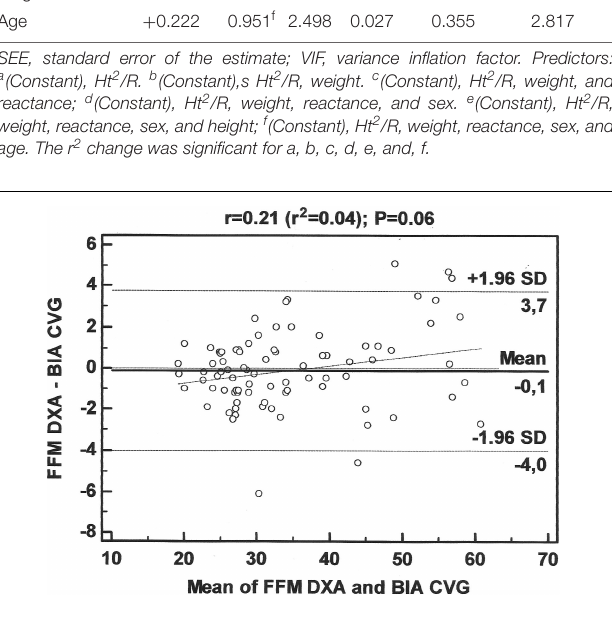
FIGURE 3 | Bland-Altman plots for the concordance limits between values determined by the reference method (DXA) and the equation for fat-free mass (FFM) in adolescents, derived in this